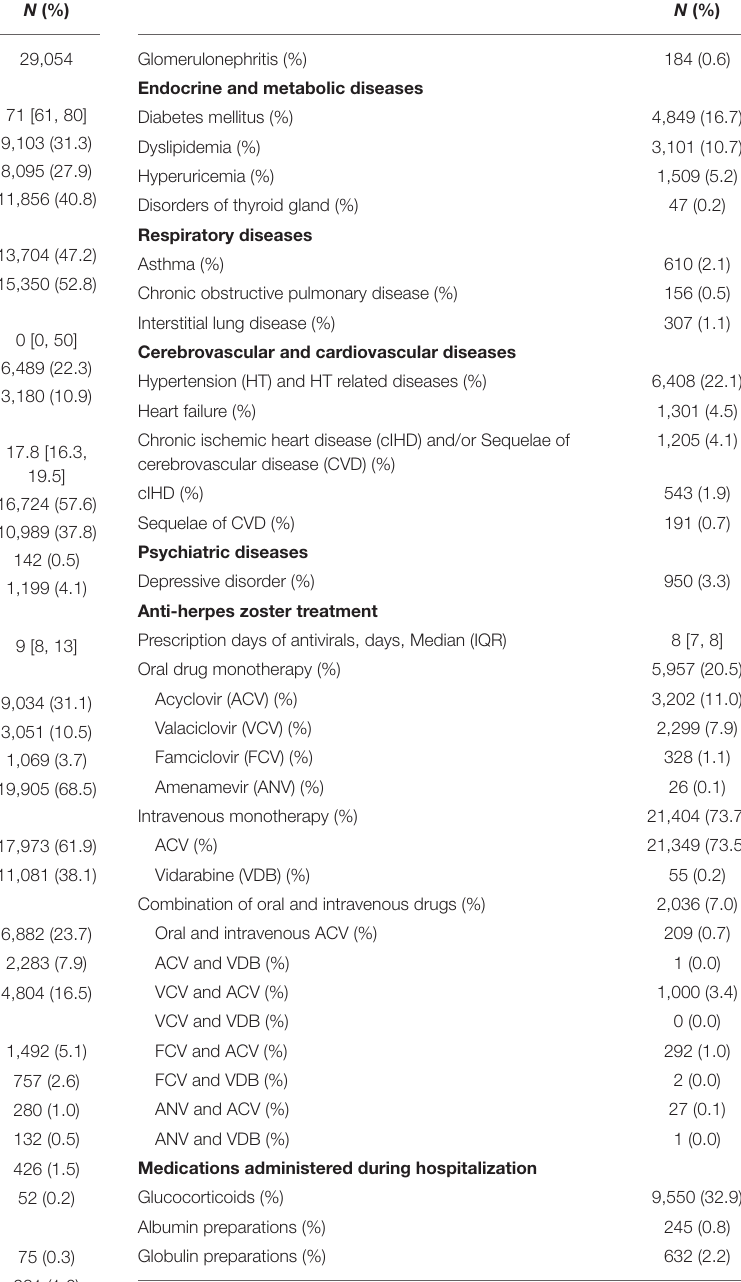
TABLE 1 | Patient